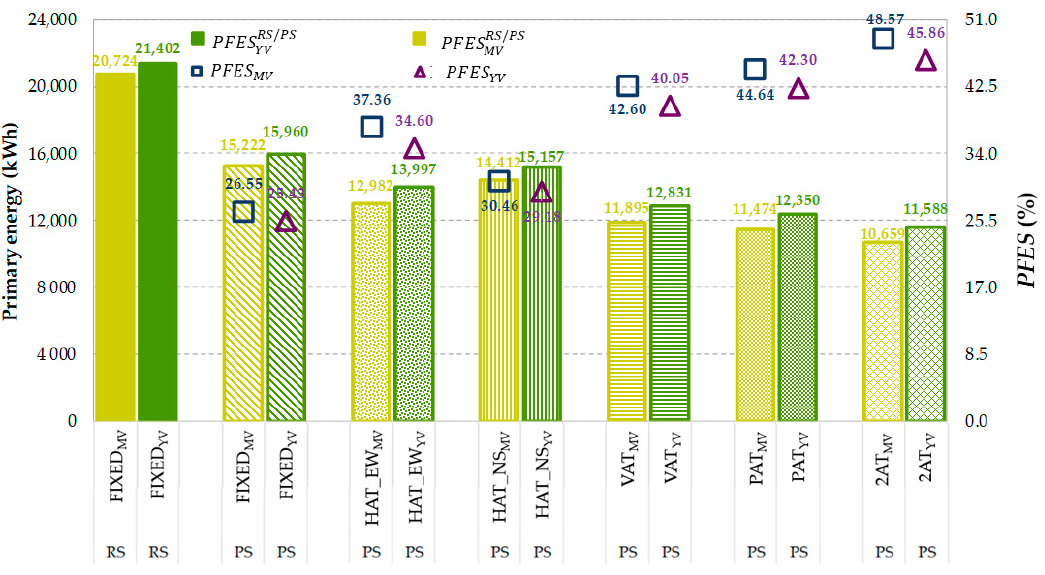
Figure 11. Energy analysis on annual basis in both Scenario_MV and YV.